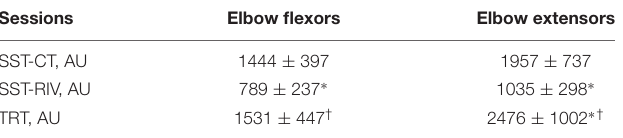
TABLE 1 | Mean ± SD total training volume (TTV) of elbow flexors, and elbow extensors for sarcoplasma stimulating training contraction type (SST-CT), SST rest interval variable (SST-RIV), and traditional resistance training (TRT) sessions.